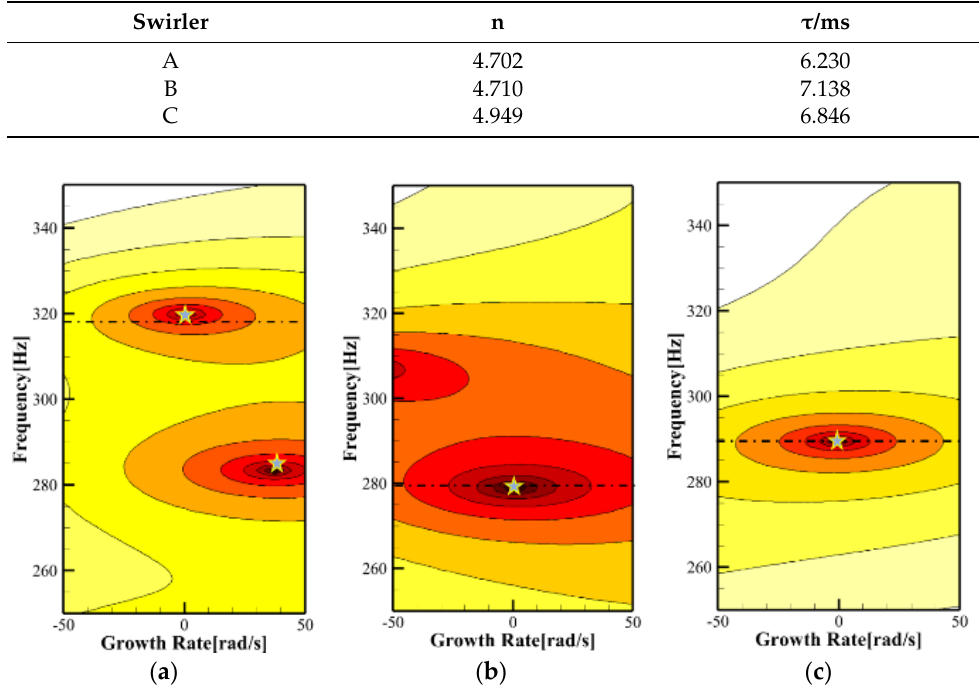
Figure 10. Modal distribution of three swirler schemes under optimized FTF. ( a ) Swirler A; ( b ) Swirler B; ( c ) Swirler C. (The pentagram represents the characteristic mode, and the dotted line is the characteristic frequency measured in the test)